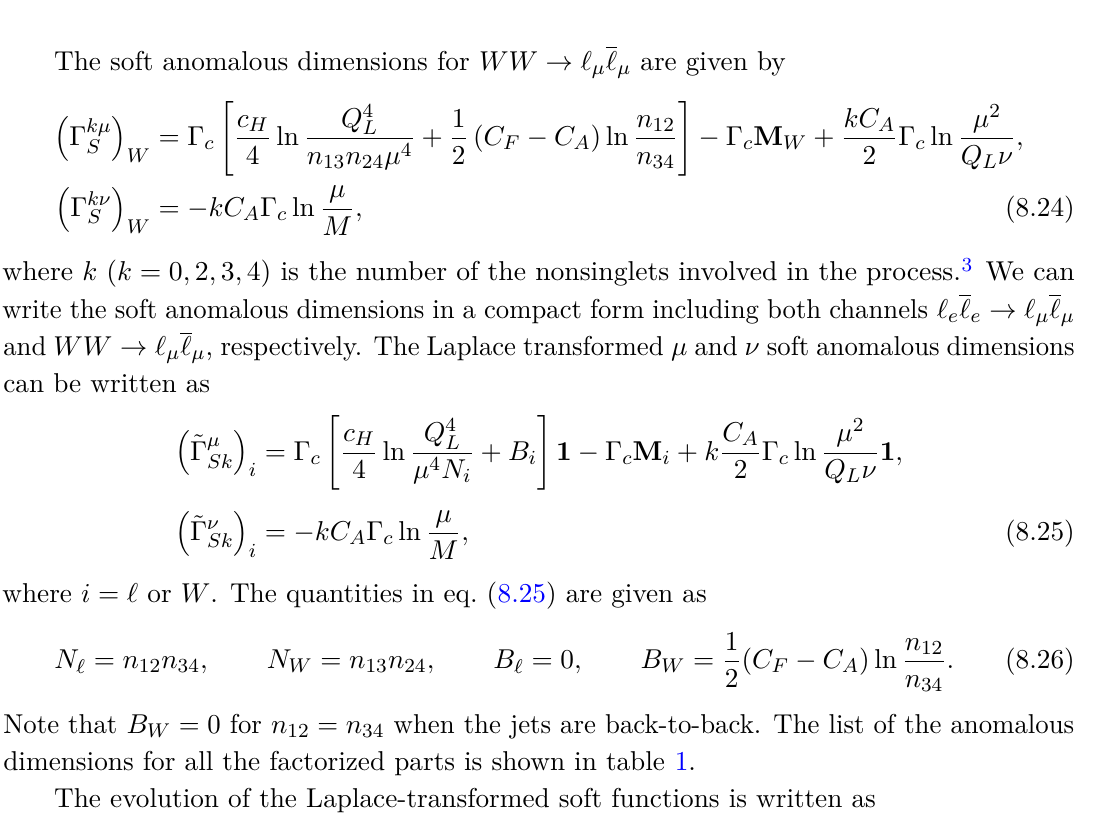
Table 1 . Anomalous dimensions of the factorized